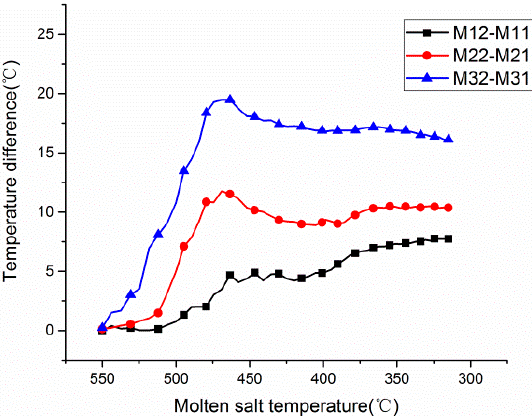
Figure 5. Variations in the temperature difference of the temperature stratification zone.